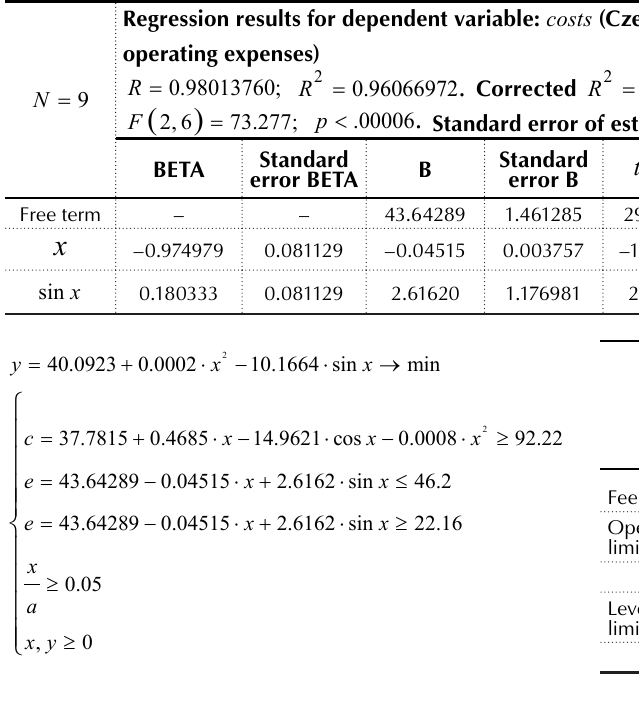
( ) e from the volume of the fund